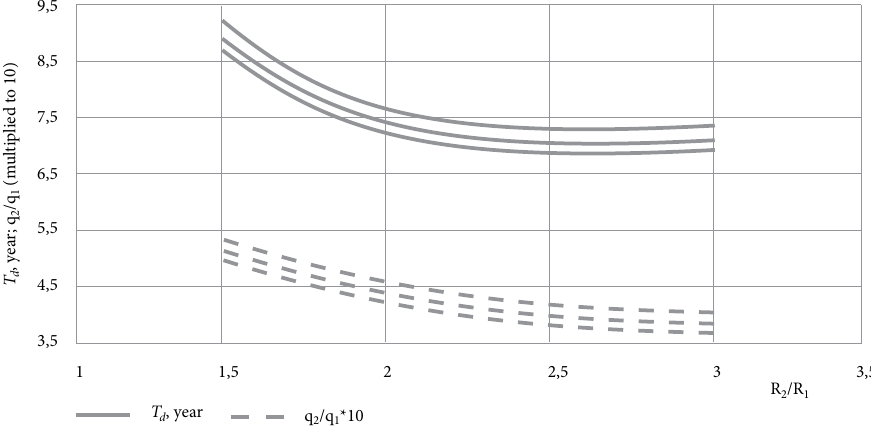
fig. 3. The same to Fig. 1, but for conditions of